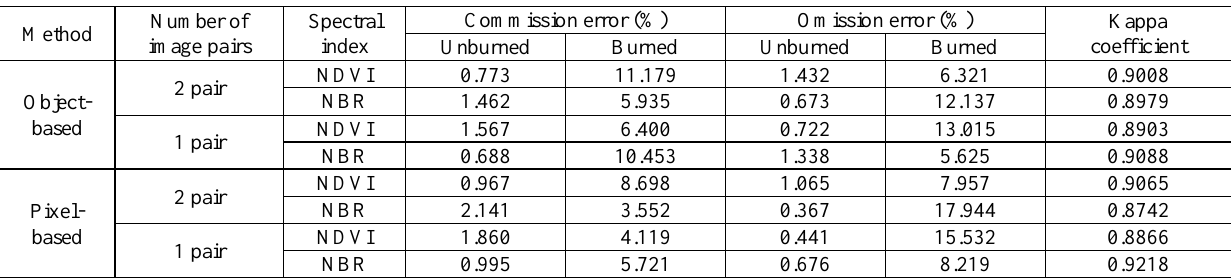
Table 5. Accuracy assessment (Commission error, omission error, Kappa